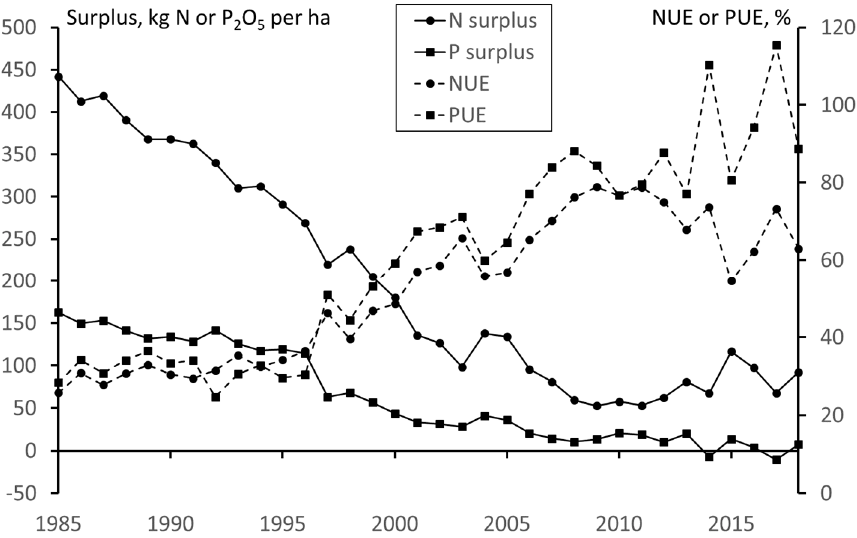
Figure 4. N and P surpluses and N and P use efficiencies of silage maize cropping systems on sandy soils in the Netherlands in the 1985–2018.